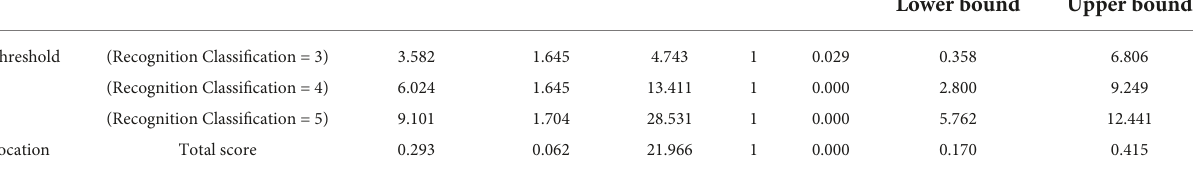
TABLE 6 Parameter estimates.